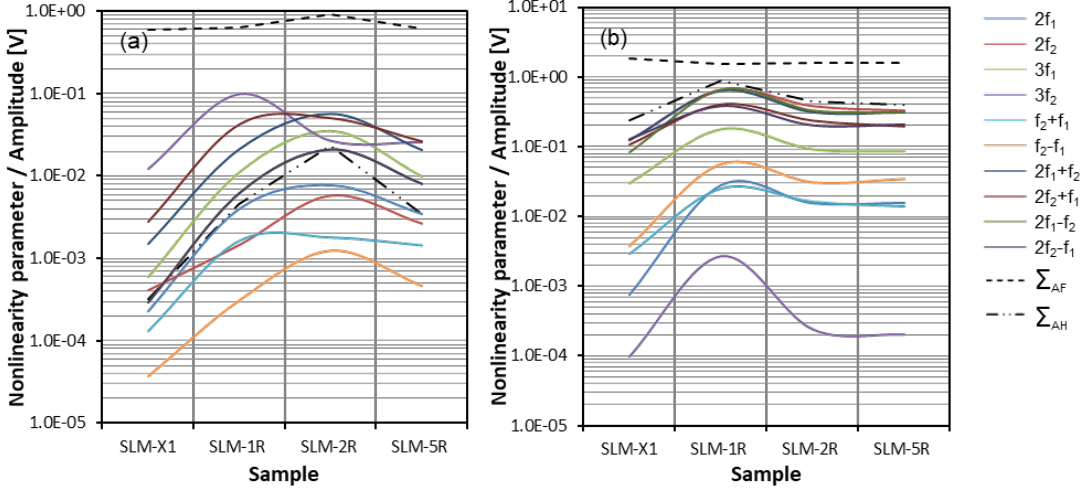
Figure 26. Nonlinearity parameter: ( a ) f 1 = 3 MHz, f 2 = 5 MHz, α = 90°; ( b ) f 1 = 4 MHz, f 2 = 5 MHz, α = 90°.